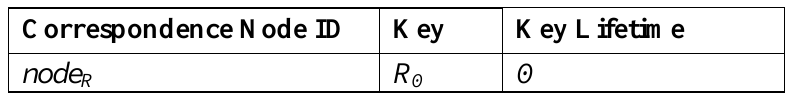
Table 2. The initial key entry.